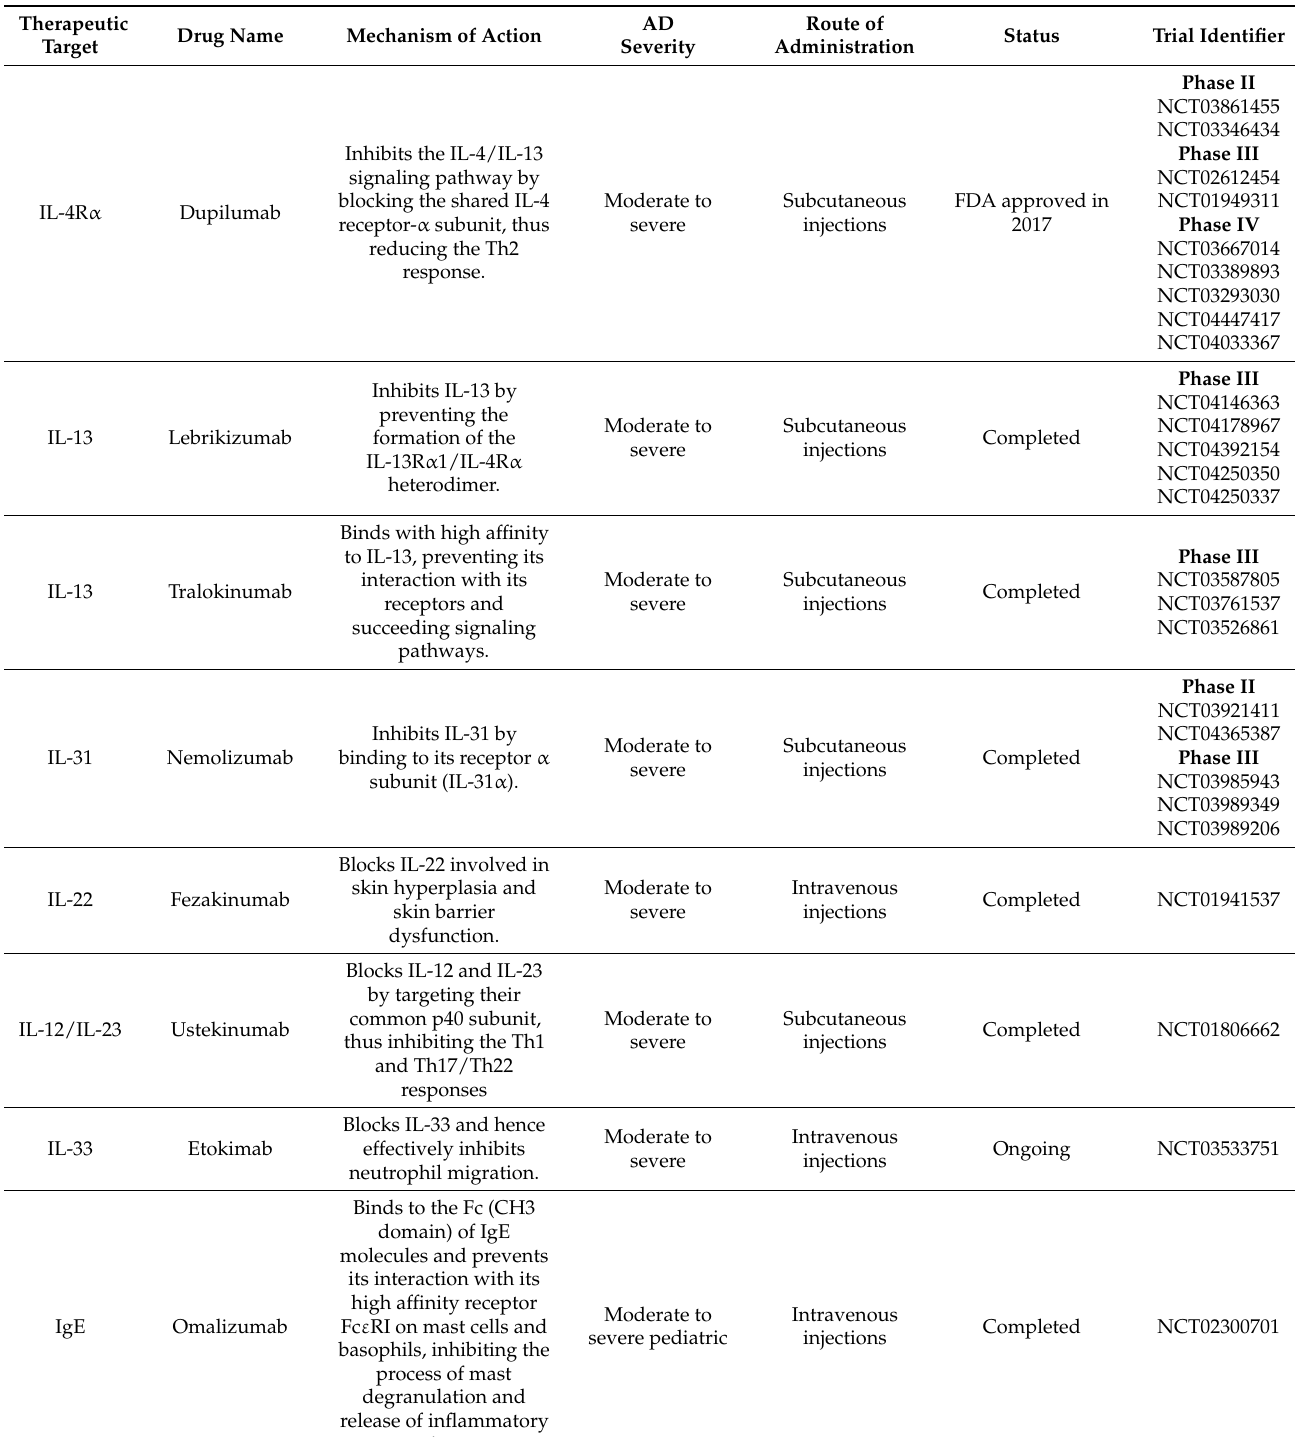
Table 1. Emerging systemic therapeutic biologics (monoclonal antibodies) for